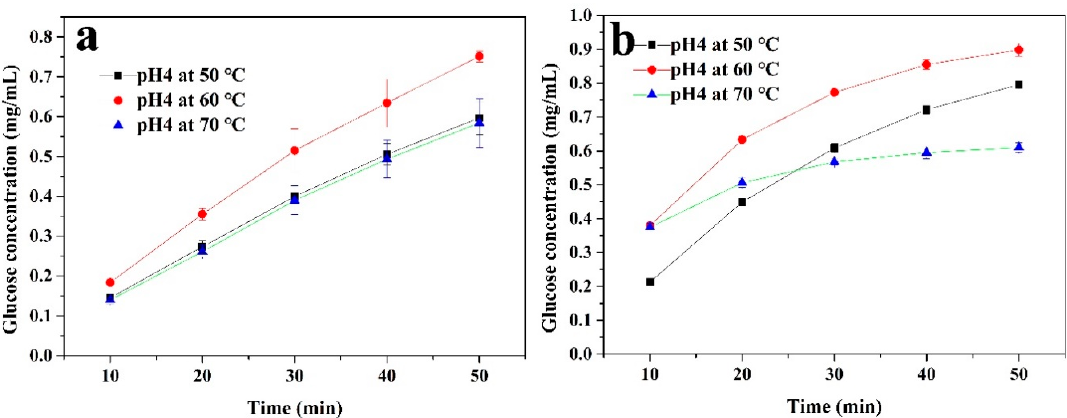
Figure 8. The glucose produced from the ( a ) immobilized and ( b ) free cellulase by hydrolyzing a 1% CMC solution at pH 4 with different temperatures for 50 min.